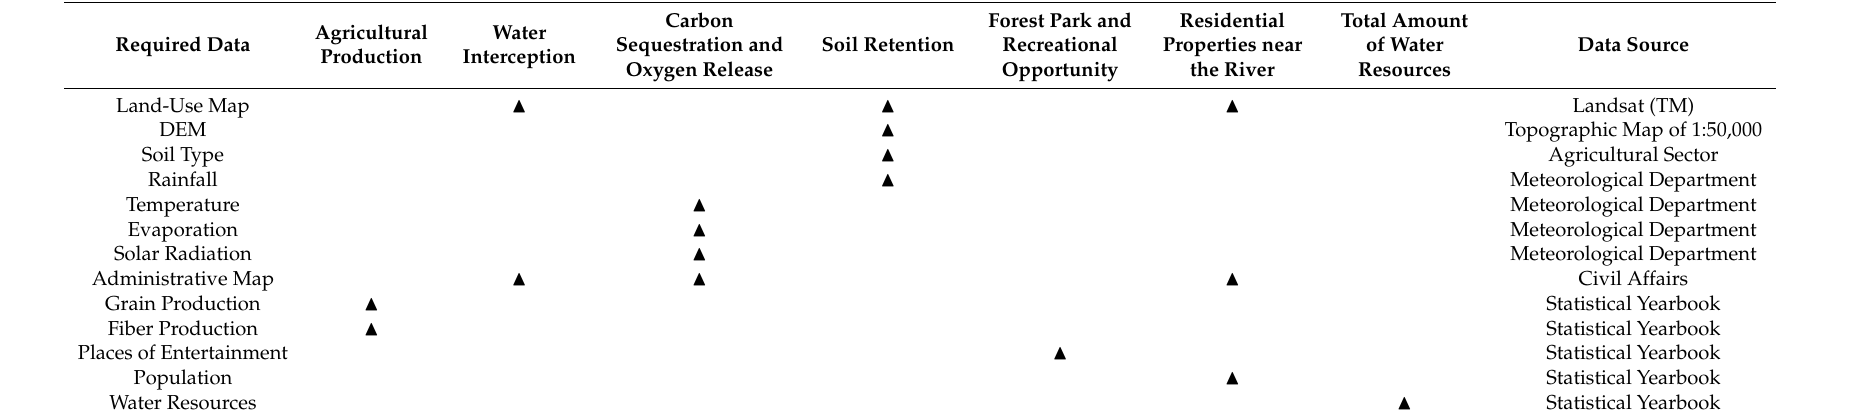
Table 3. Data and data